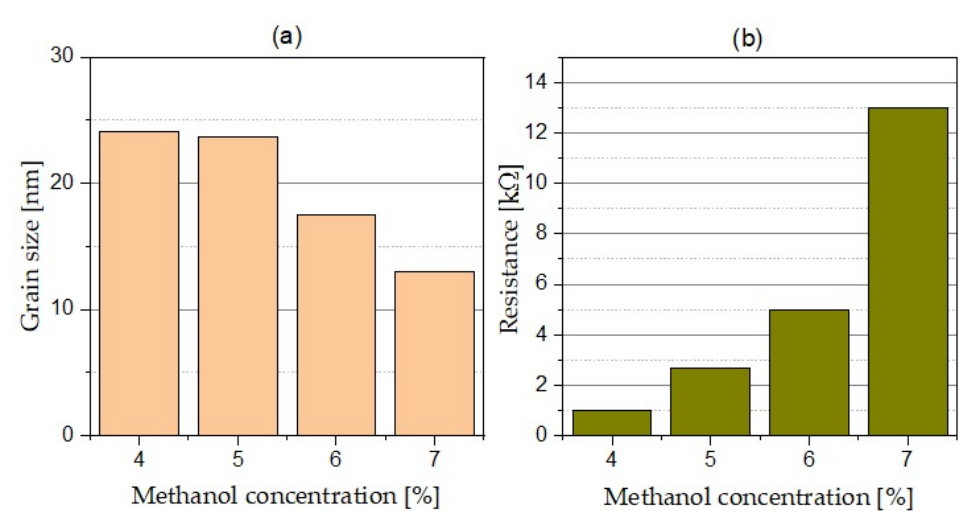
Figure 3. Methanol vapour content for diamond films on the basis of: ( a ) grain size and ( b ) layer resistivity.